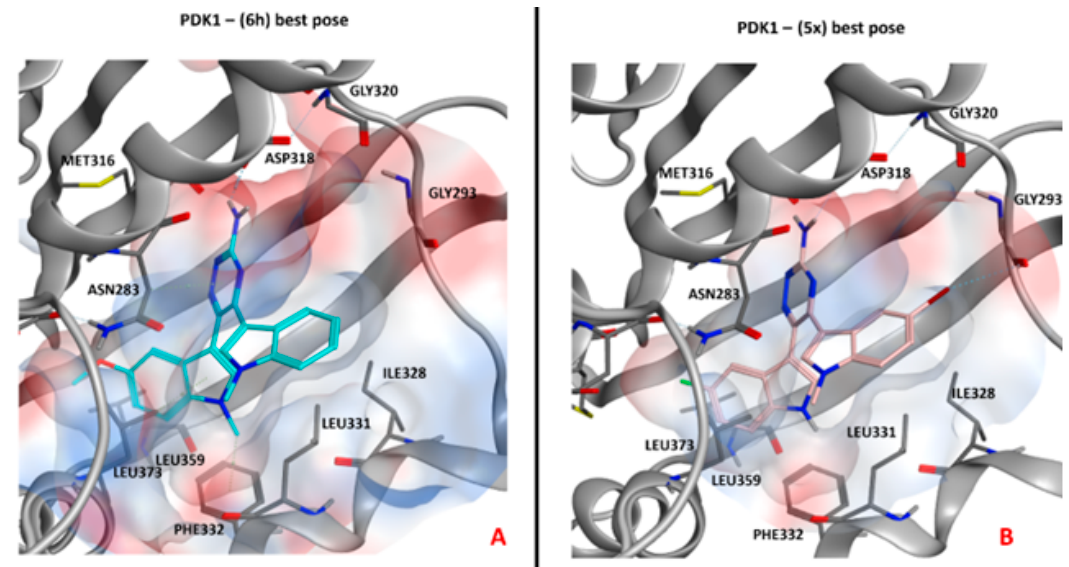
Figure 5. Depiction of the binding modes of the two compounds chosen as the reference for our study, located in the PDK1 ATP-binding site. ( A ) Representation of the binding pocket’s electrostatic surface for the selected pose produced by molecular docking of the ligand 6h (colored cyan), which has passed through the steric and electrostatic filtering procedures. ( B ) Picture showing the binding pocket’s electrostatic surface for the selected pose produced by molecular docking of the ligand 5x (colored in pink), which has passed through the steric and electrostatic filtering procedures. The images were created and rendered with MOE.